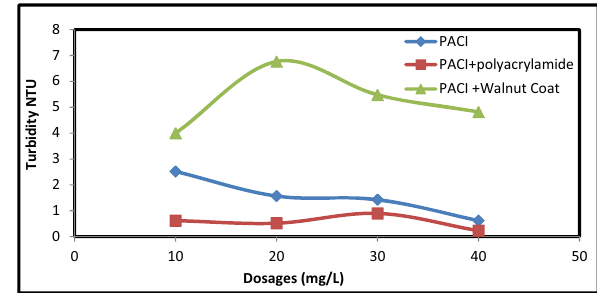
Figure 17: The relation between the coagulants and the fi nal residual turbidity for samples at 300 cm height.